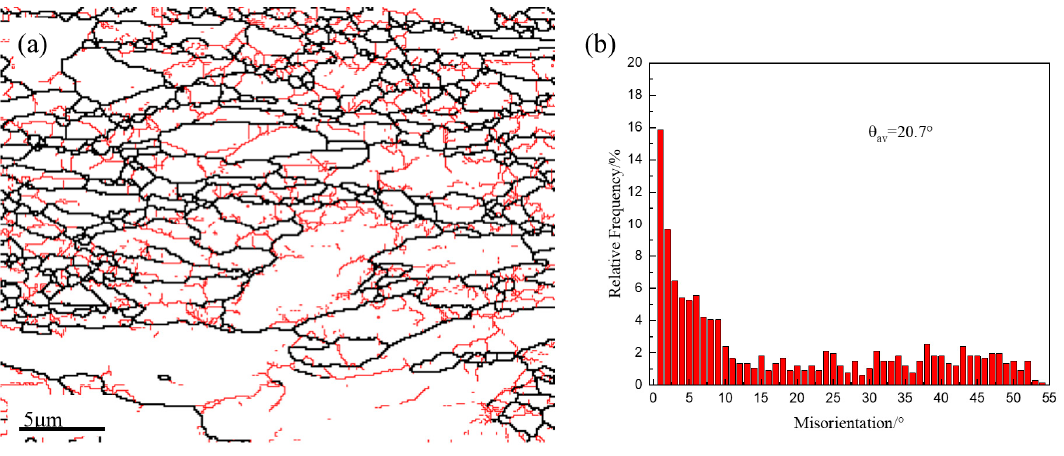
Figure 3. ( a ) Grain boundary image and ( b ) corresponding misorientation angle distribution of the 15Cr-Al-Zr-ODS alloys after TMP in the ND–RD section.